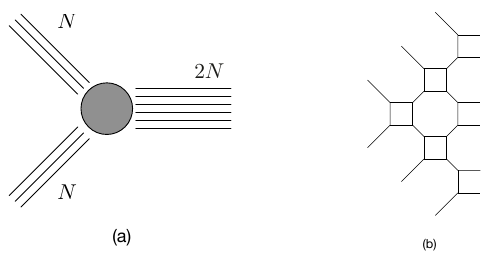
Figure 3. The S-dual of the Y N web shown in (cid:12)gure 2, with a deformation to a quiver gauge theory. where i; j = 3 ; : : : ; N . These are ( N 2) 2 operators in the ( 1 ; 1 ) representation. Altogether (cid:0) these operators provide ( N +2) 2 of the components of the (( 2N ) 2 ; N ; N ) operator. asym